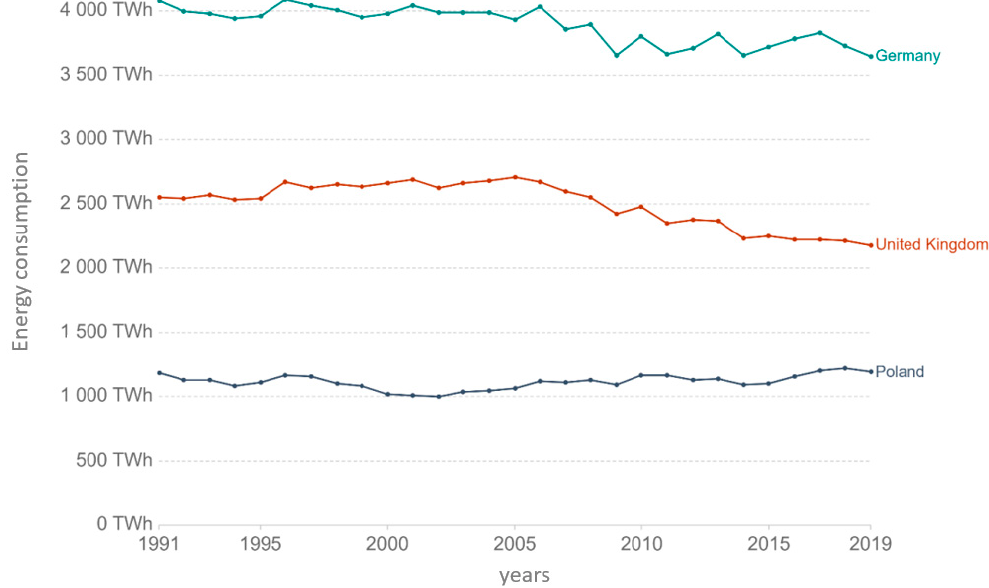
Figure 3. Primary energy consumption in terawatt-hours (TWh)—selected countries. Source: [1]. Table 1. Energy use in commercial and public services (selected countries).